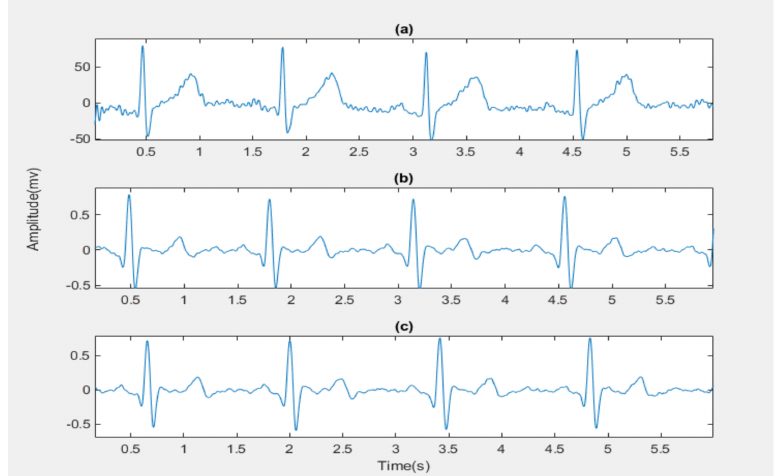
Figure 3. The preprocessing stages for normal ECG signal for example: ( a ) The Original ECG signal; ( b ) The Preprocessed ECG signal; ( c ) The ECG signal starting with the P-wave and ending with the T-wave.